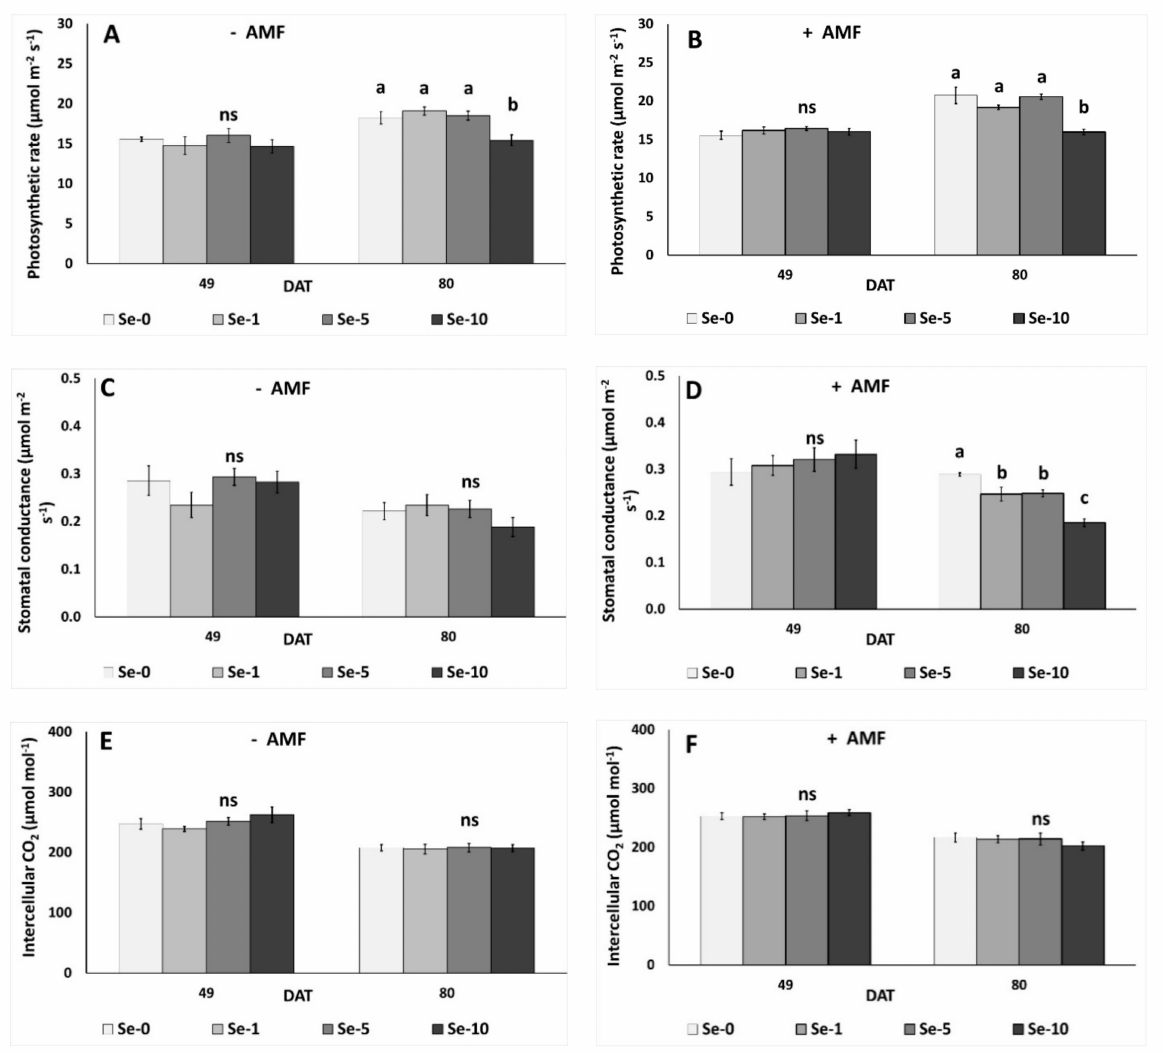
Figure 1. Effects of arbuscular mycorrhizal fungi (AMF) inoculation and selenium (Se) levels (0, 1, 5 and 10 mg L − 1 ) in the nutrient solution plant physiology in hydroponically grown strawberries in cocosoil. ( A , B ) photosynthetic rate, ( C , D ) stomatal conductance, and ( E , F ) internal CO 2 concentration. Significant differences ( p < 0.05) among selenium treatments are indicated by different letters. Error bars show SE (n = 8). Days after transplanting: